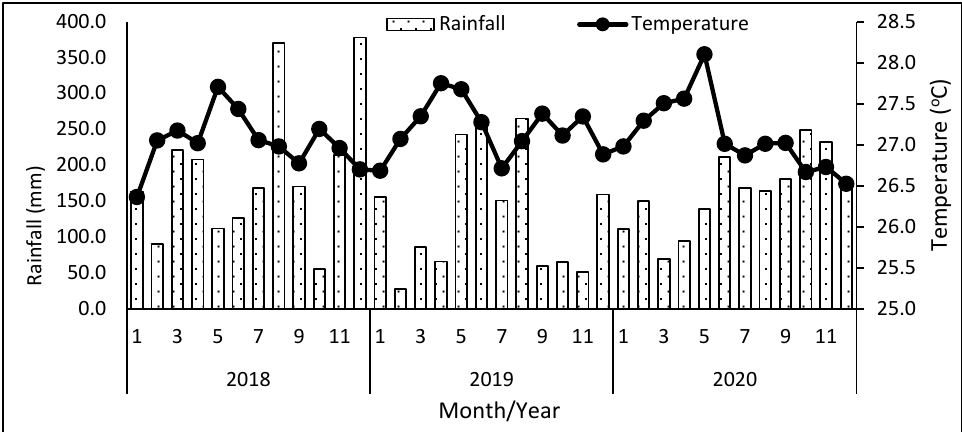
Figure 2. Monthly mean rainfall (mm) and temperature (°C) at study site, 2018–2020. The data was provided by the Malaysian Meteorological Department [23].